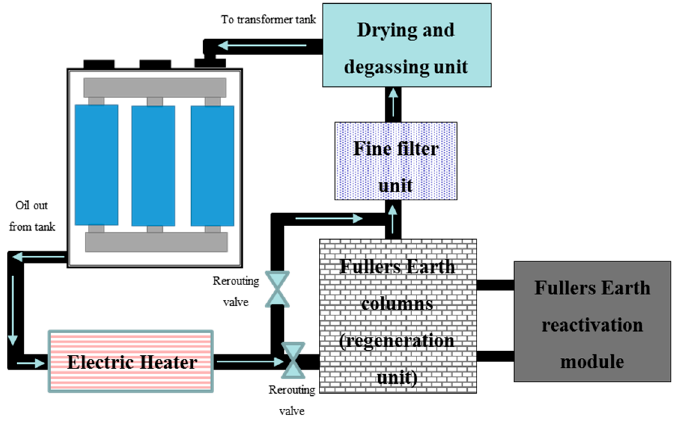
Figure 3. Schematic diagram of the oil regeneration system.